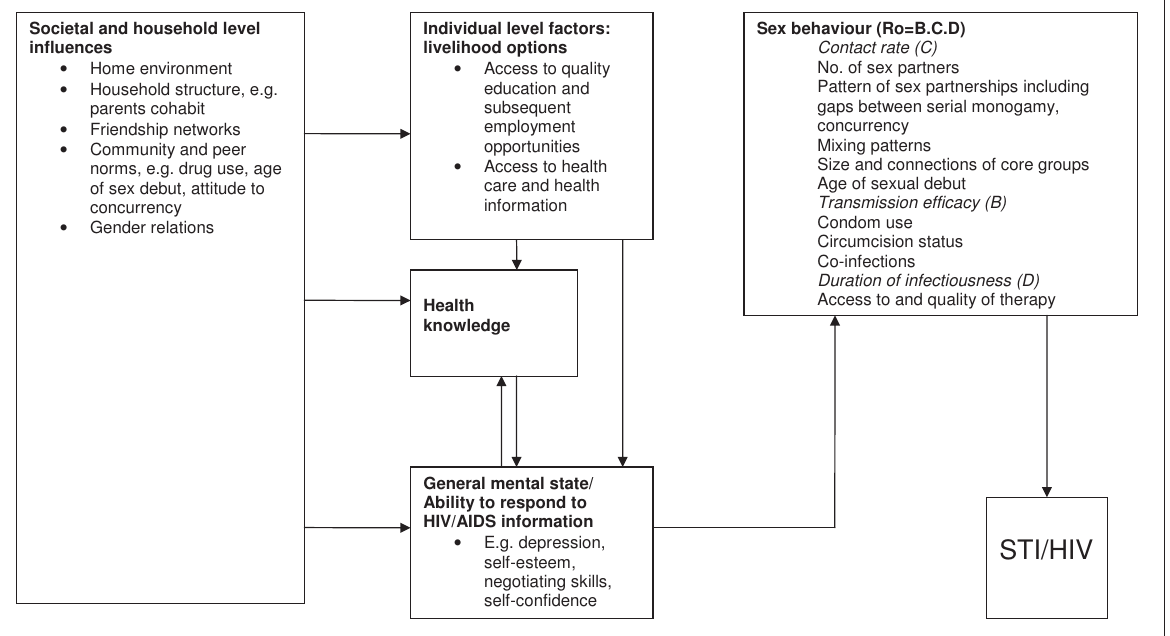
Fig. 3. Conceptual framework of the determinants of STI in young persons (based on Hallman 20 ).